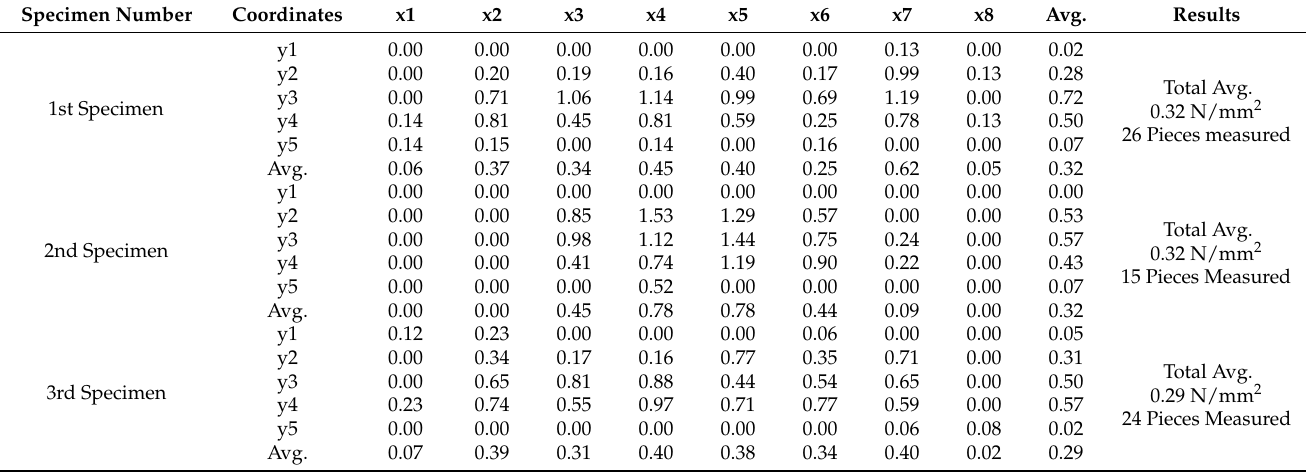
Table 8. AR 80 ± 2% specimen result.